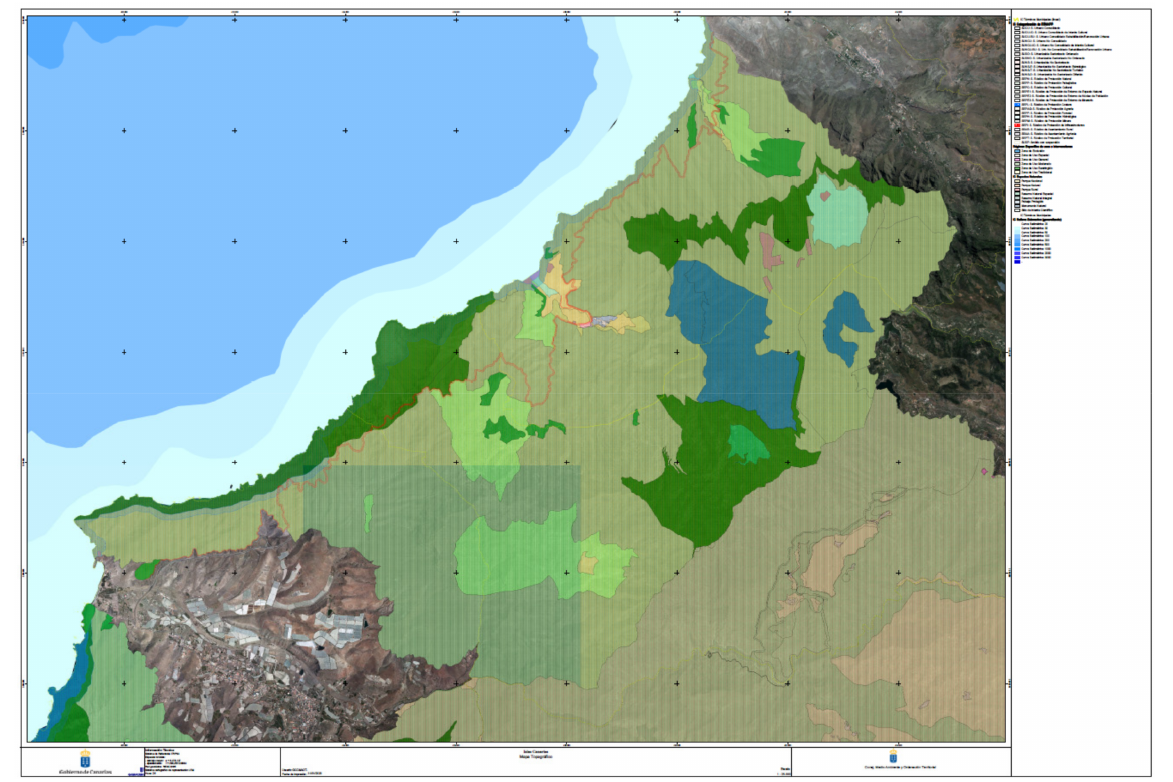
Figure A3. Map of land use in the area of Tamadaba, Gran Canaria. Source: Government of the island of Gran